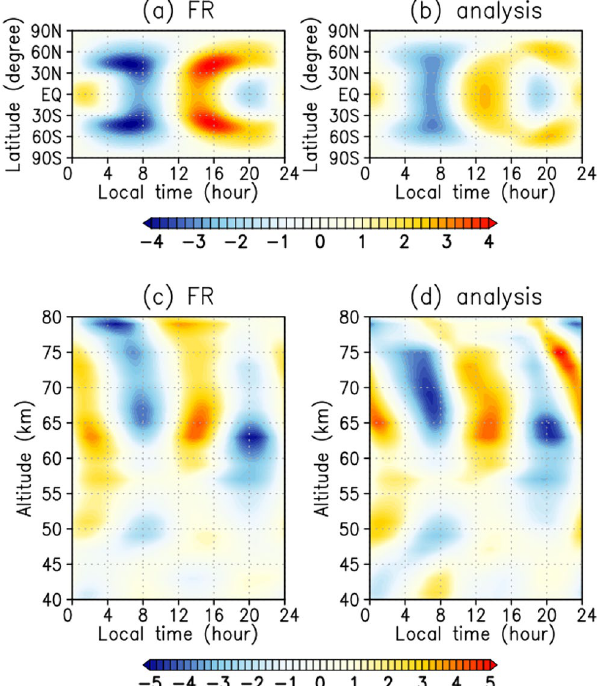
Figure 2. ( a , b ) Local time and latitudinal distributions at the cloud-top altitudes and ( c , d ) local time and vertical distributions at the equator of temperature (K) associated with the thermal tides: ( a , c ) FR and ( b , d ) analysis. ( a , b ) Vertically averaged distributions with the weighting function 48 are plotted to compare with the results of LIR observations. ( c , d ) Amplitudes are scaled with the square root of the density at each altitude divided by the density at 70 km altitude for visibility. Data are averaged for the two Earth months at each altitude in a reference frame moving with the Sun to extract the structures associated with thermal tides. Deviations from the zonal means of temperature are